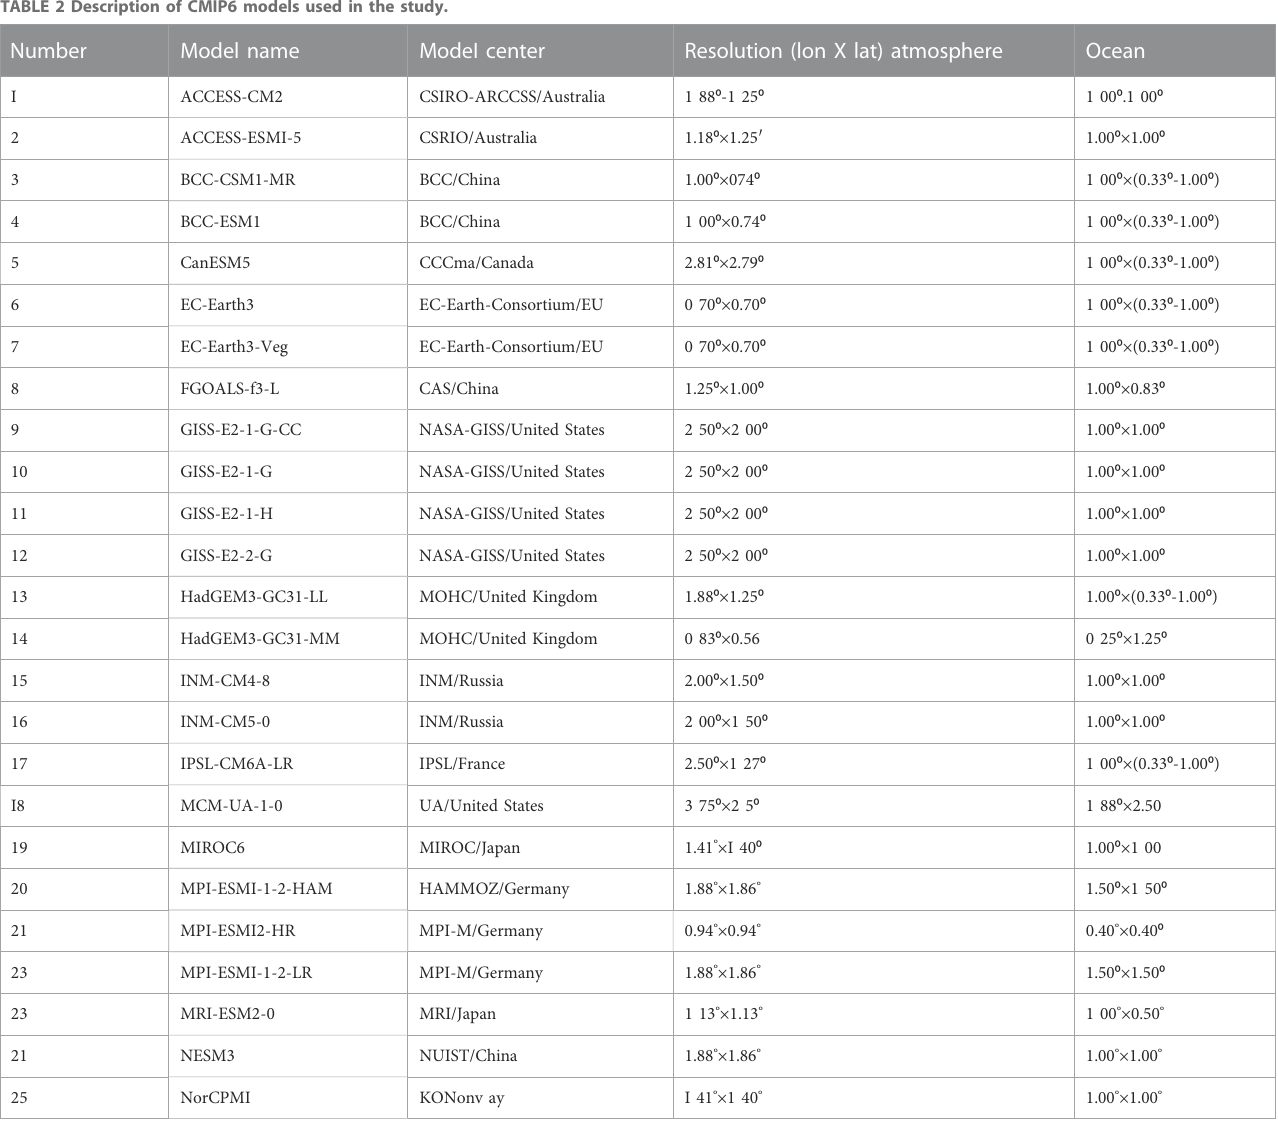
TABLE 2 Description of CMIP6 models used in the